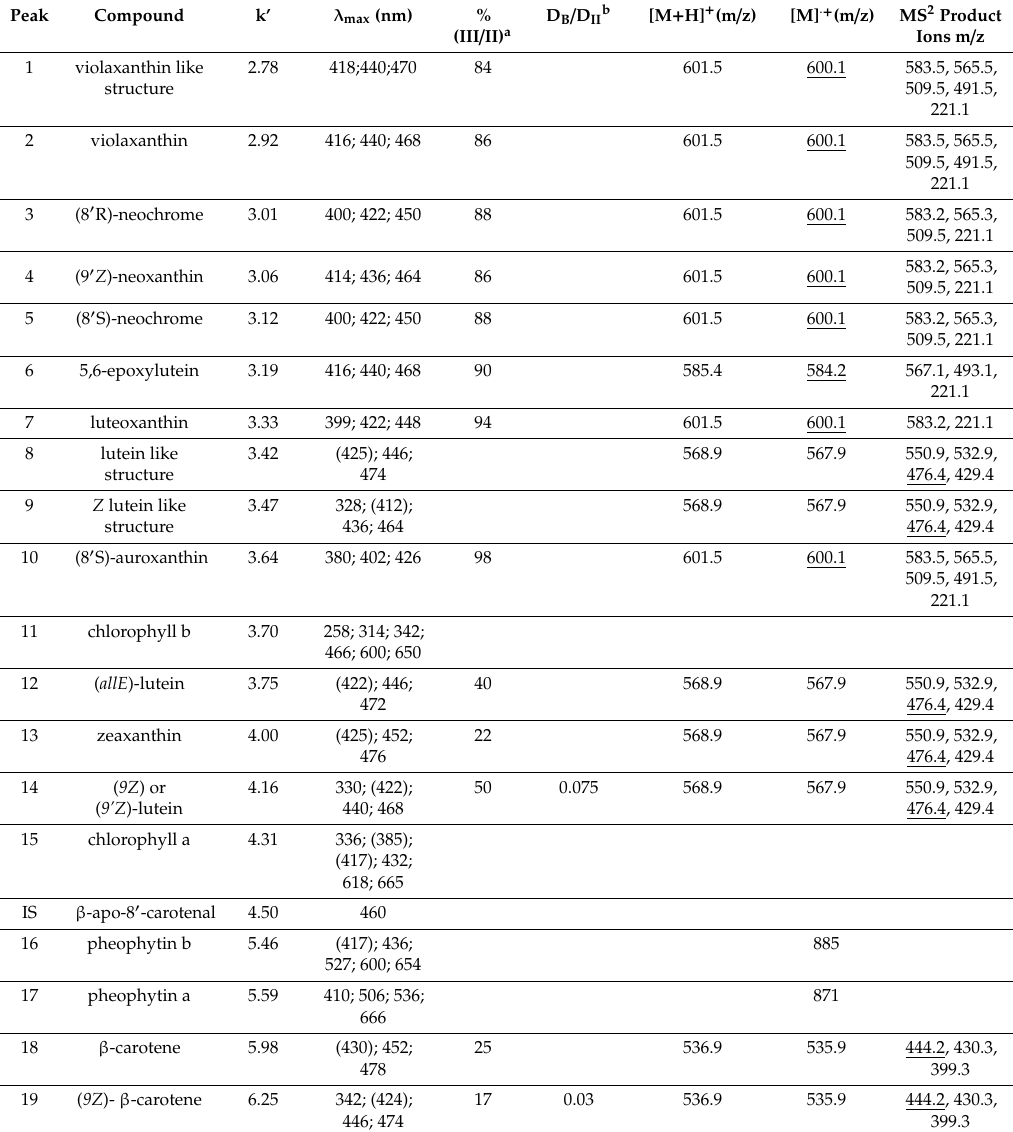
Table 1. HPLC-DAD-MS (ESI + ) characteristics of carotenoids in